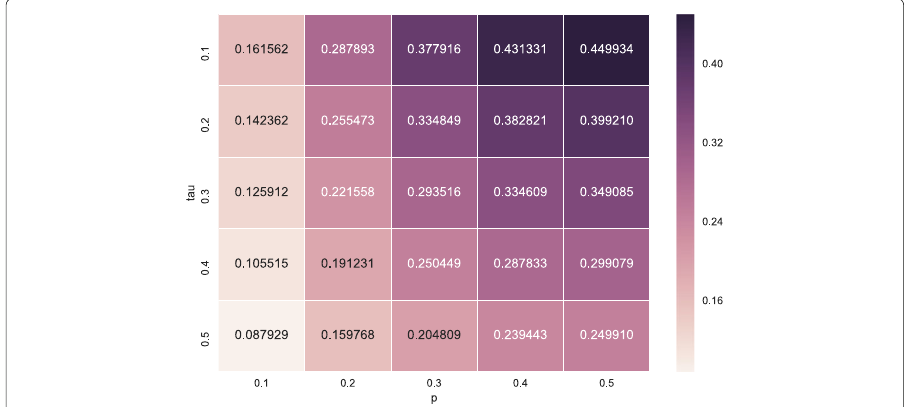
Fig. 3 Network: polblogs, proportion of cross group ties on synthetic networks generated from the original graph